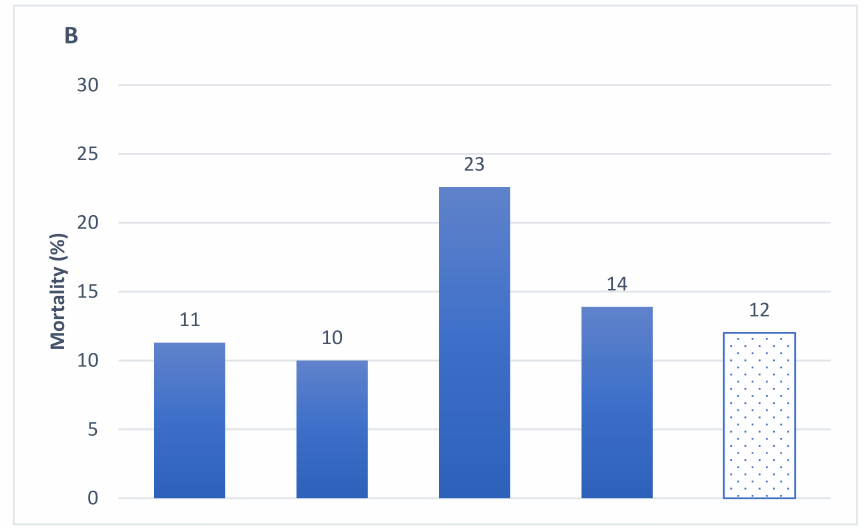
Figure 3. All-cause mortality by LTCH size in privately owned and administered LTCHs, Community of Madrid, March–April 2020 ( A ) For-profit ( B ) Nonprofit.